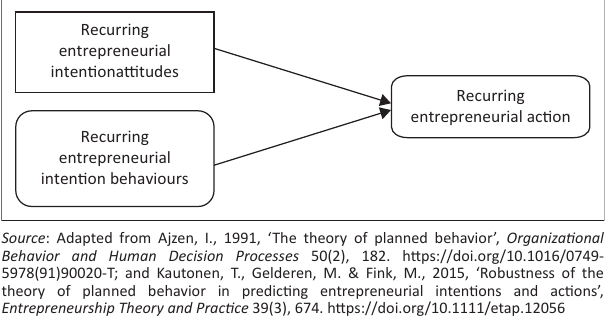
FIG URE 2: The relationship between recurring entrepreneurial intention and recurring entrepreneurial